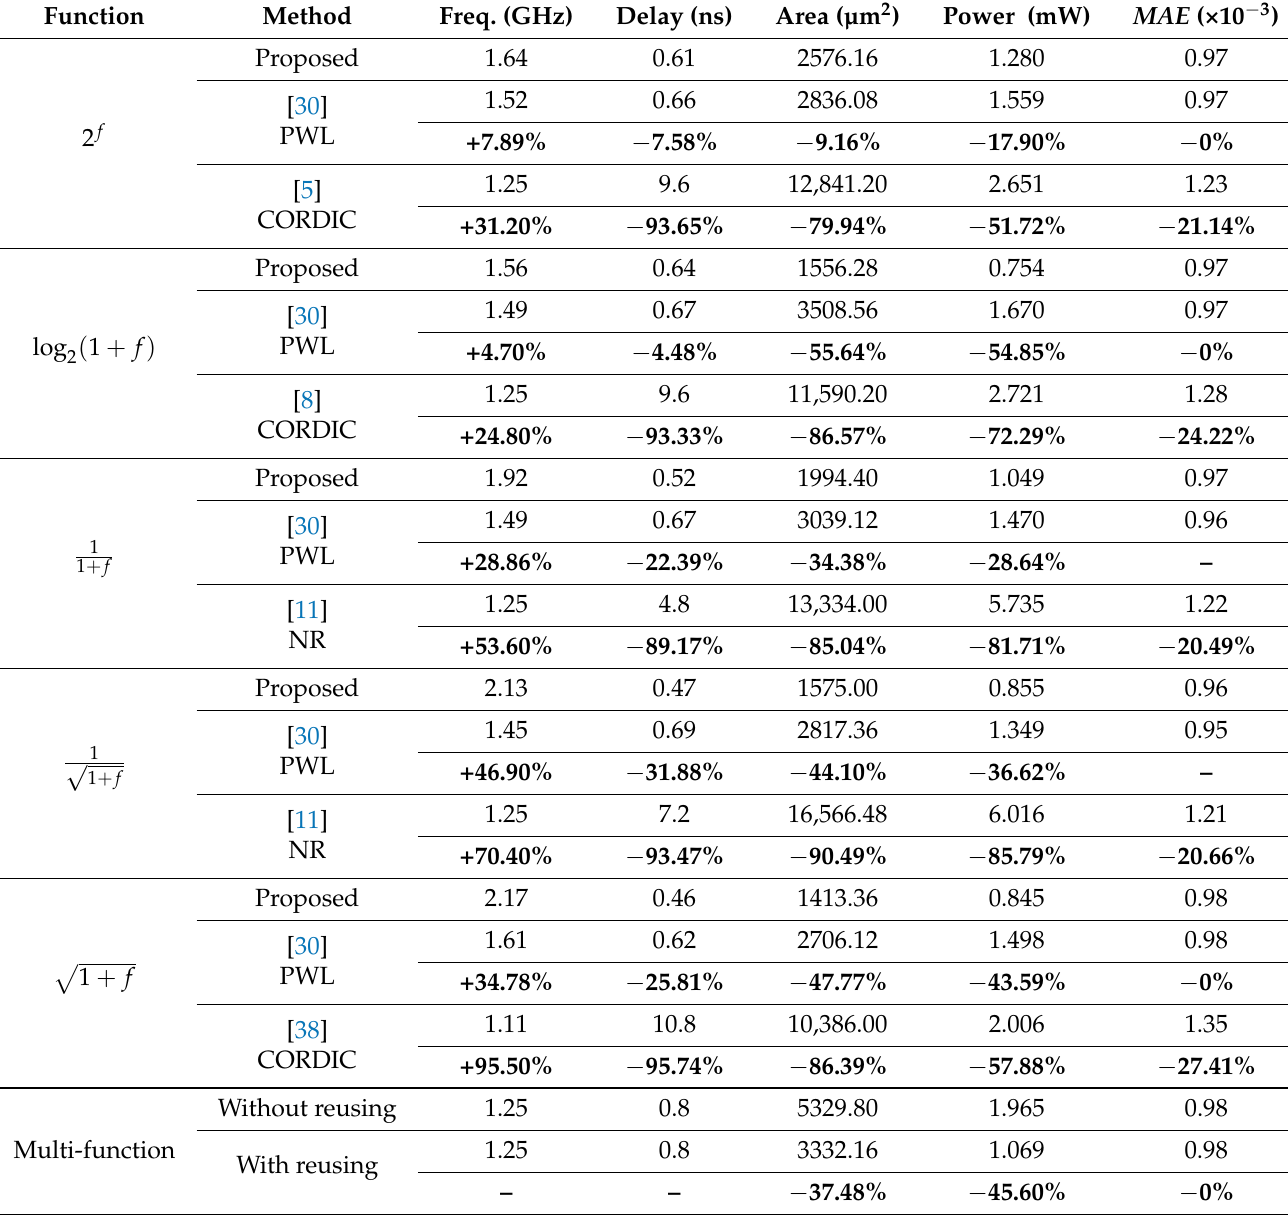
Table 3. Application-specific integrated circuit (ASIC) implementation results of our design and the designs considered for